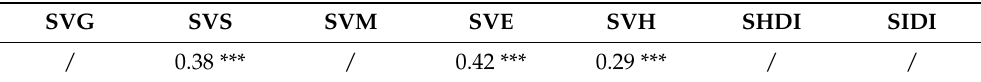
Table 4. The factor detector results of DSP on visual perception factors in public space. SVG SVS SVM SVE